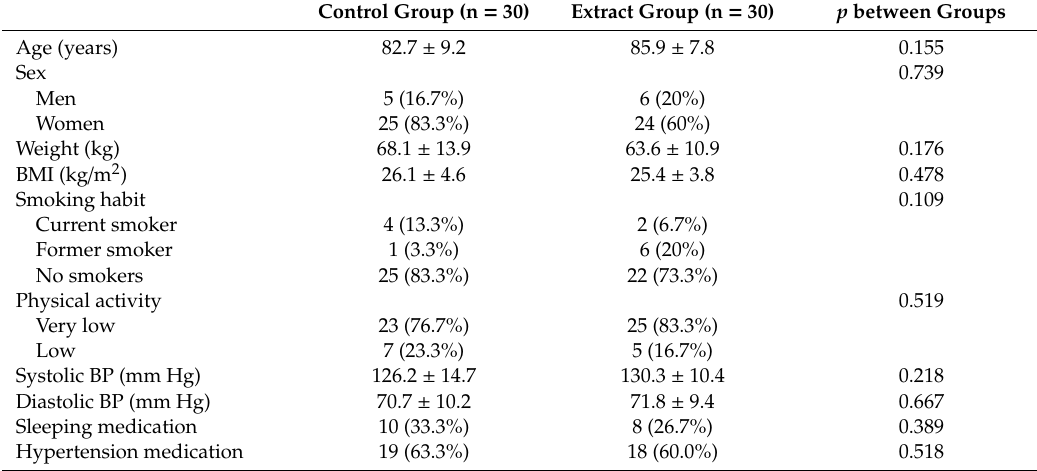
Table 1. Baseline characteristics of the subjects participating in the study.